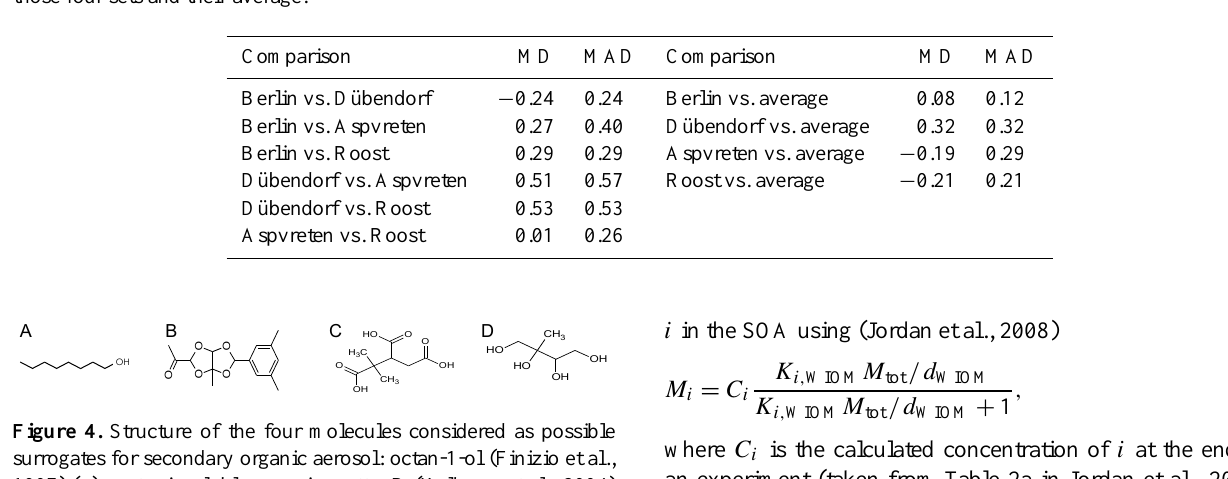
Table 2. Mean difference (MD) and mean absolute difference (MAD) between the four sets of ppLFER-predicted K i, WIOM and between those four sets and their average.